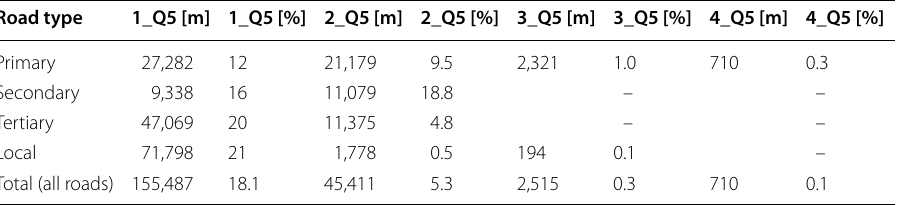
Table 2 Length of road segments classified in the most critical quintile ("Q5"), based on the number of scenarios